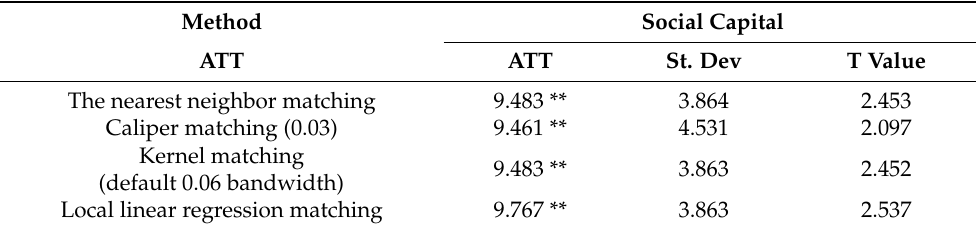
Table 9. The impact of MWE on social capital: PSM model